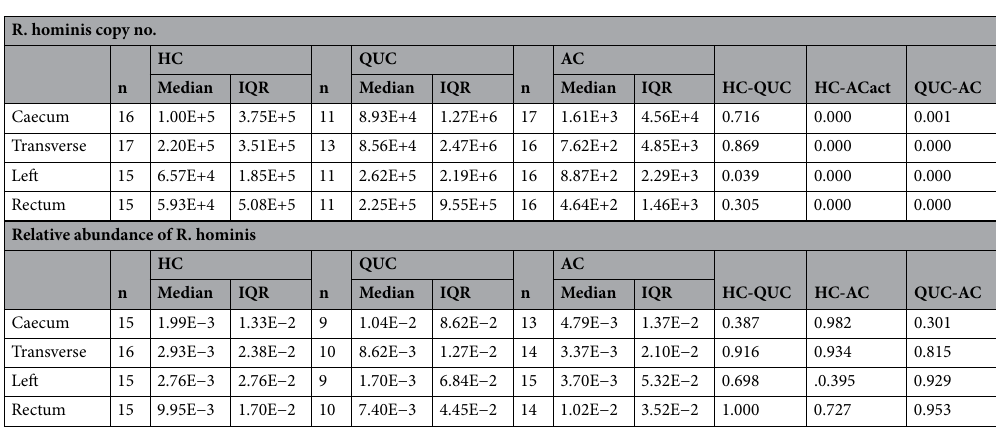
Table 4. Comparison of R. hominis copy number and relative abundance on a loco-regional basis.